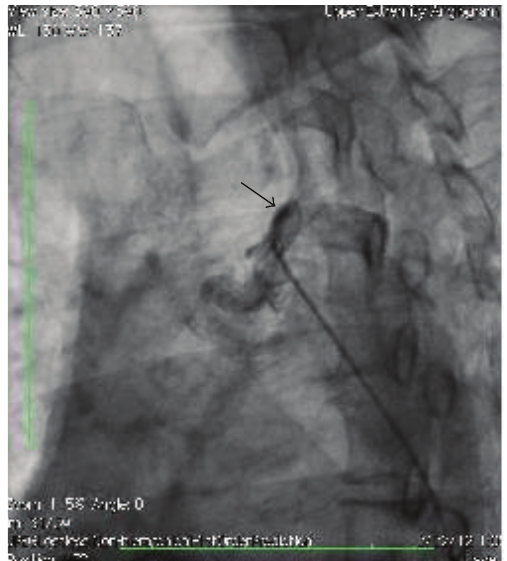
Figure 3: Angiogram showing significant in-stent stenosis.